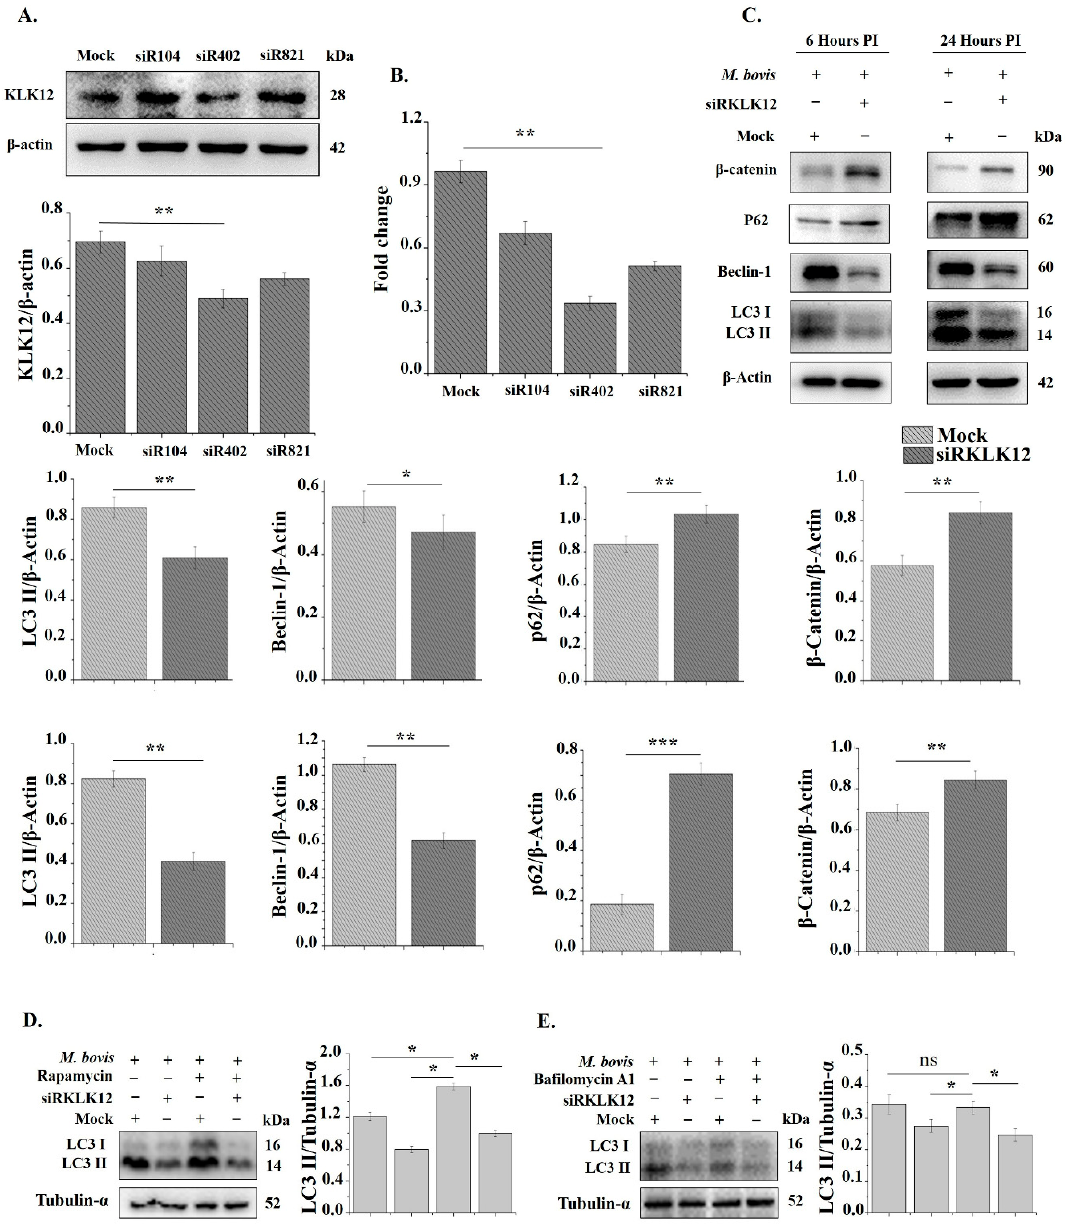
Figure 3. Knockdown of KLK12 impairs autophagy induction in M. bovis C68004 infected murine